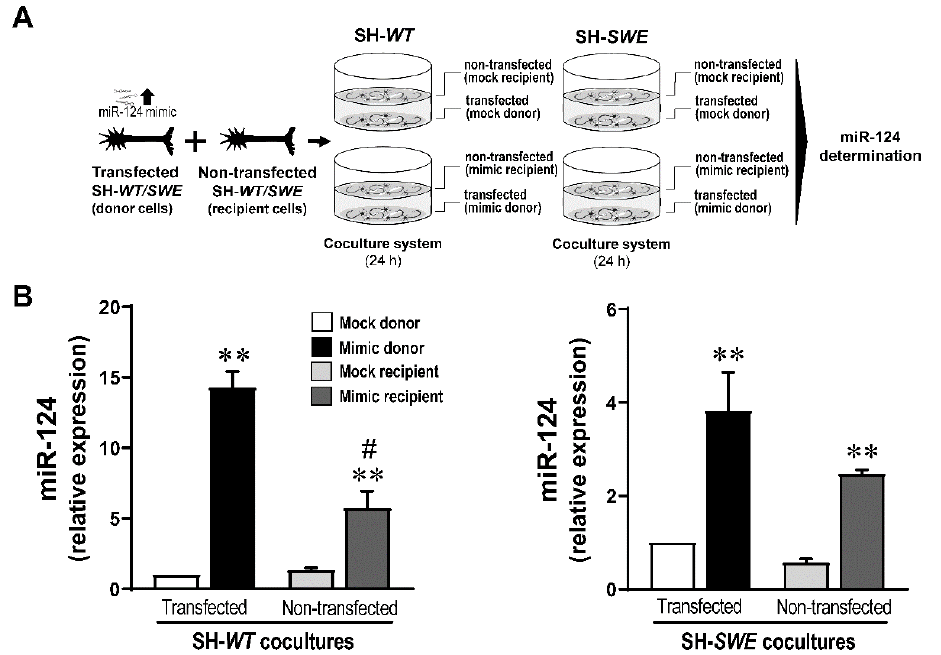
Figure 6. miR-124 is transmitted from donor to recipient neurons in a non-cell-contact co-culture system after transfection of miR-124 in SH -WT and SH -SWE donor cells. Cells were obtained, dif- ferentiated, and transfected, as detailed in Material and Methods, before being co-cultured with non-transfected matched cells (recipient) for 24 h. ( A ) Schematic representation of SH- WT and SH- SWE donor cells transfected with mock and miR-124 mimic in co-culture with the matched non- transfected recipient cells. ( B ) miR-124 expression levels in the transfected and non-transfected cells after 24 h of co-incubation. Quantification was obtained by RT-qPCR and results are mean ± SEM fold change from at least three independent experiments. ** p < 0.01 vs. mock and # p < 0.05 vs. cells modulated with miR-124 mimic, two-tailed student’s t -test. miR, miRNA; SH-WT, human SH-SY5Y wild-type neurons; SH-SWE, human SH-SY5Y expressing the APP695 Swedish mutant protein.